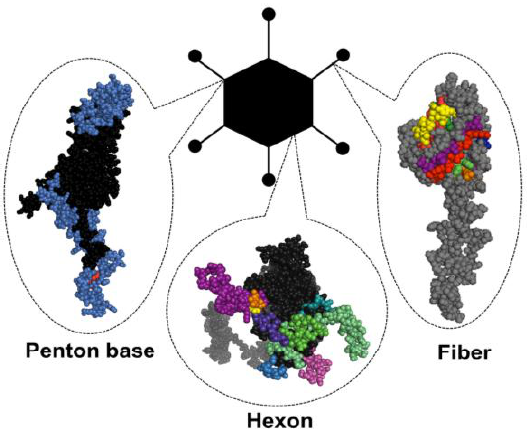
Figure 1. Adenovirus particle with the three major antigenic capsid proteins. Penton base, hexon and fiber (shown here as monomers) are the main building blocks of the capsid structure, but also contain the major immunogenic epitopes (highlighted in colors) that are explained in greater detail in Section 1.3 of this review.